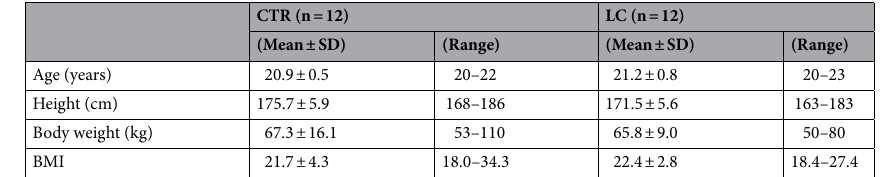
Table 2. Participant profiles in Experiment 2. Age, height, body weight, and body mass index (BMI) of the participants were matched so that they did not differ between the two groups ( p > 0.05, Mann–Whitney U